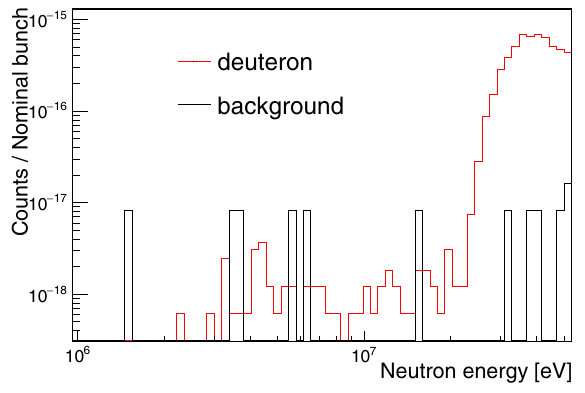
Figure 4. Deuterons count-rate (red curve) per neutron bunch as a function of neutron energy for a selected couple of thin-thick strips versus background contribution (black curve) The back- ground was estimated using an empty sample